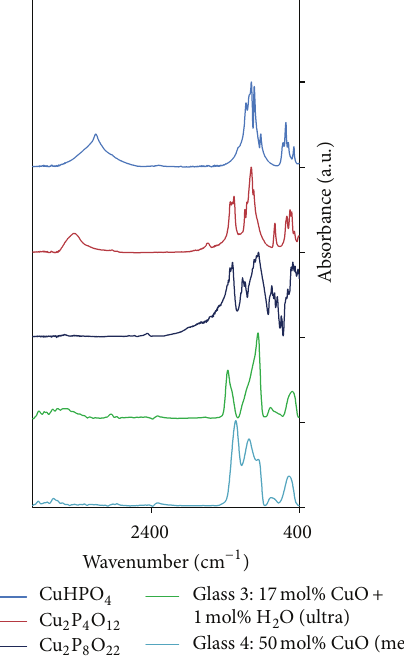
Figure 5: IR-spectra of the crystals of CuHPo 4 , Cu 2 P 4 O 12 , Cu 2 P 8 O 22 , the ultraphosphate glass 3, and the metaphosphate glass 4.